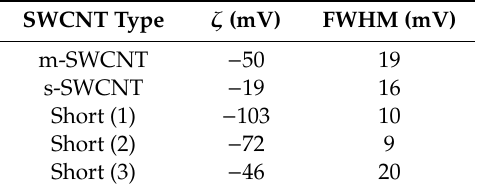
Table 2. Zeta potential of SWCNT